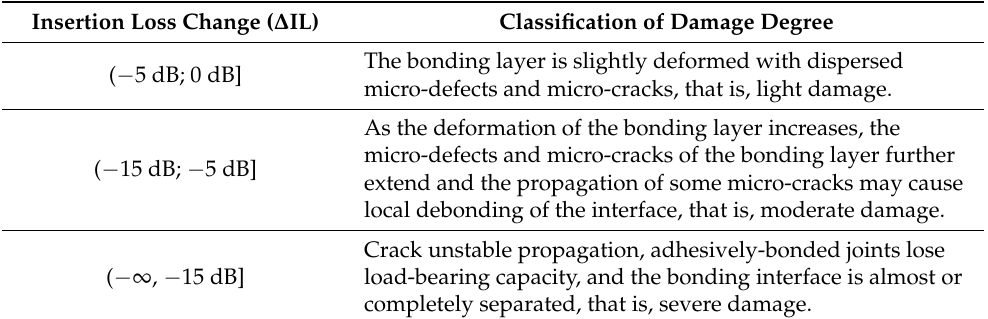
Table 2. The corresponding relationship between ∆ IL at 1.55 µ m wavelength and the damage degree of PLC optical